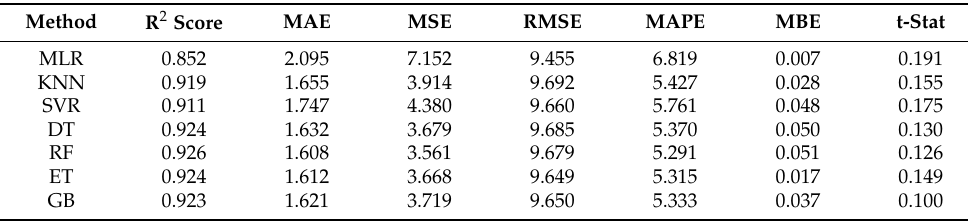
Table 5. Performance measures of applied